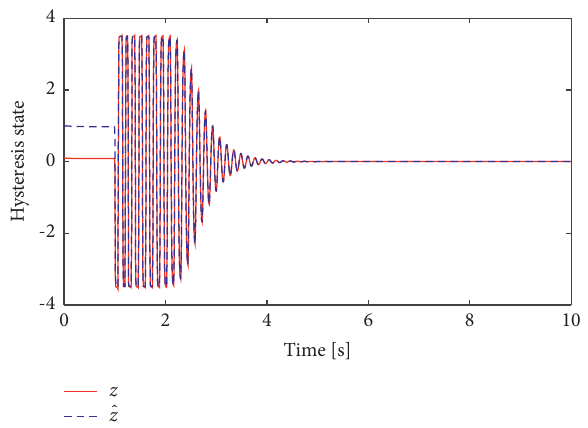
Figure 13: Time history of the hysteresis state.